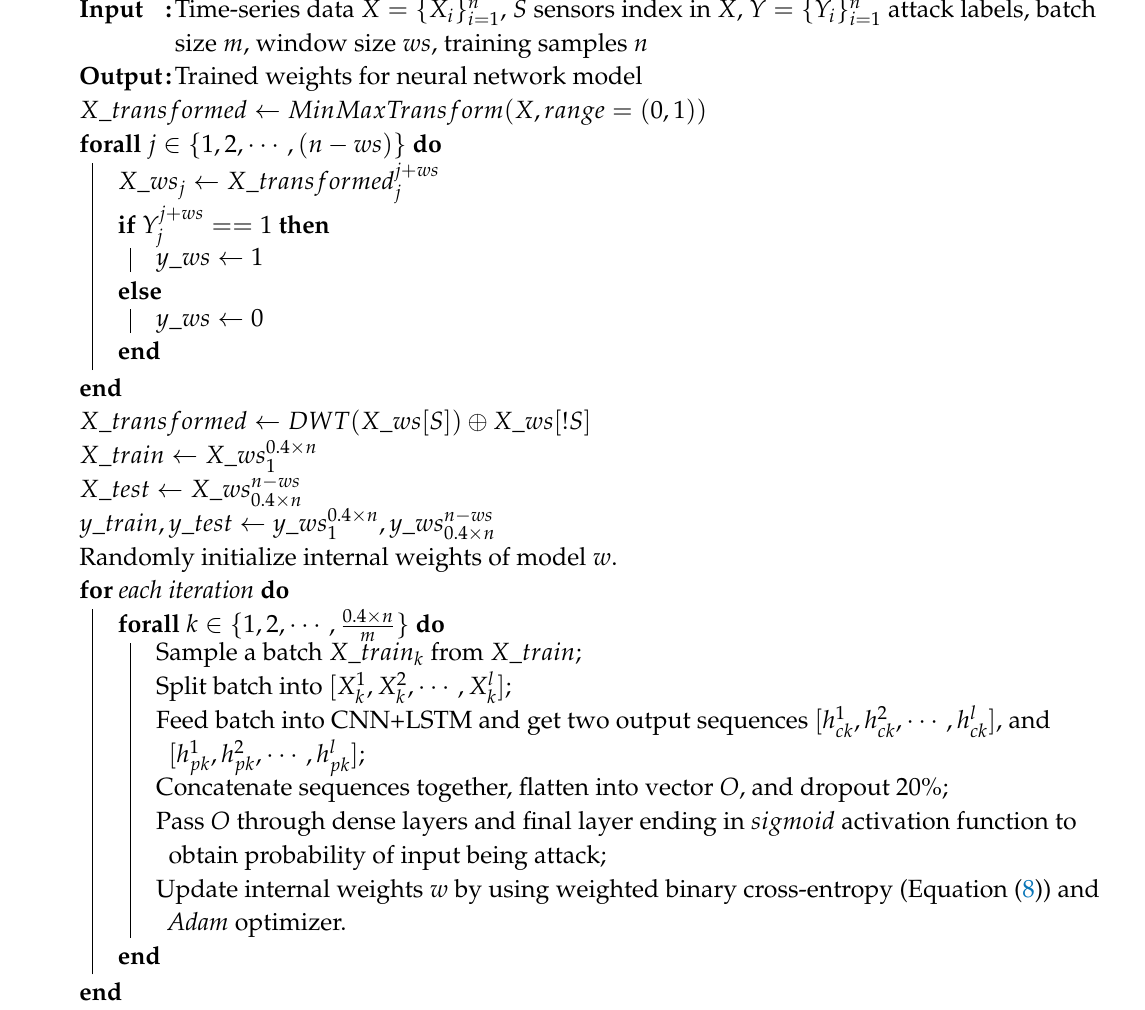
Algorithm 1: Summary of